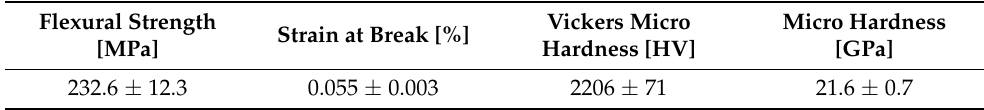
Table 5. Mechanical properties of 3D-printed sintered alumina.